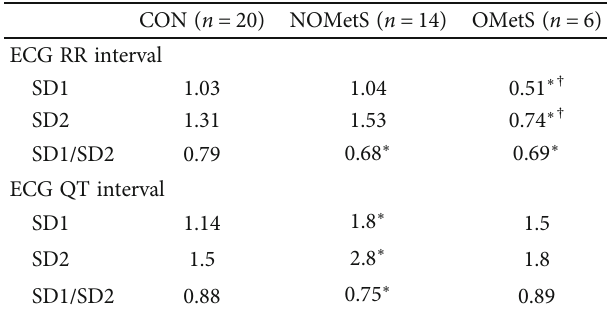
Table 1: Metabolic Characterization of animal model. Table 2: Heart rate